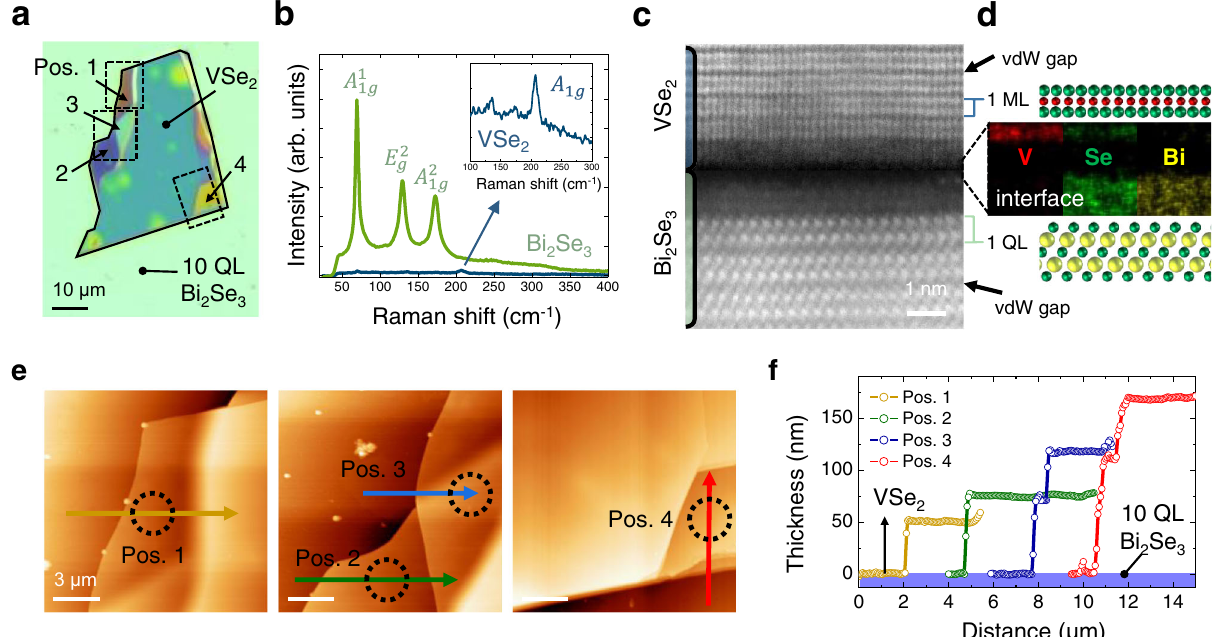
Fig. 1 Structural information and morphology of VSe2/Bi2Se3 heterostructures (VBHs). a Optical image of VBHs. The regions of interest are marked as positions 1-4. The black solid line marks the boundaries of the VSe 2 fl ake and the black dashed line indicates the VSe 2 region of interest for this study. b Raman spectra of VSe 2 and Bi 2 Se 3 . Inset, enlarged Raman spectra of VSe 2 . Each Raman active mode is indicated. c Cross-sectional high-angle annular dark- fi eld scanning transmission electron microscopy (HAADF-STEM) image of a VBH. The interface between VSe 2 and Bi 2 Se 3 shows the empty space of the carbon protective layer deposited before slice cutting by a focused ion beam. The clear vdW gap and atomic con fi guration are shown. d Corresponding energy-dispersive X-ray spectroscopy (EDS) elemental intensity maps for V, Se, and Bi along with a related schematic of the atomic structure. Note that the data of cross-sectional HAADF-STEM and EDS, which are required for deposition of carbon protecting layer, were collected after completing pump – probe experiments. e Atomic force microscopy (AFM) topography images of VBHs at positions 1 – 4. The dashed circles indicate the spots of interest in the pump – probe measurements. The scale bar is the same for all three images. f Height pro fi les along with the arrows at positions 1 – 4. Note that the measured height is the thickness of VSe 2 on Bi 2 Se 3